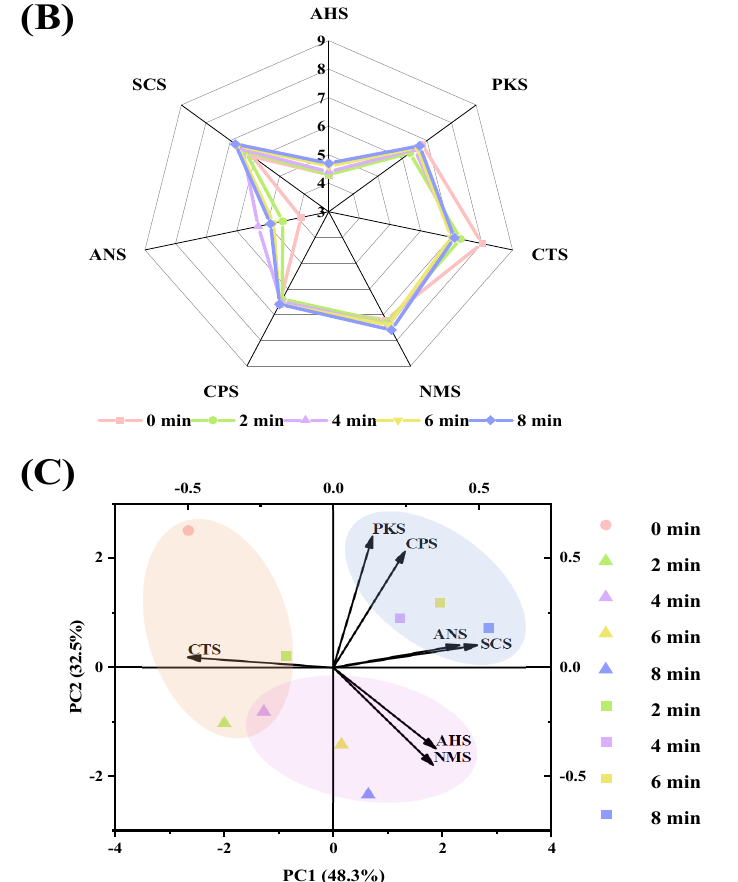
Figure 1. Radar chart of E-tongue in tamarix lamb roasted by charcoal ( A ) or electric ( B ) and their principal component biplots ( C ) (AHS, CTS, NMS, ANS, and SCS represented sourness, saltiness, umami, sweetness, and bitterness, respectively. PKS and CPS represented complex taste. Triangle or square represented tamarix lamb roasted by charcoal or electric, respectively).